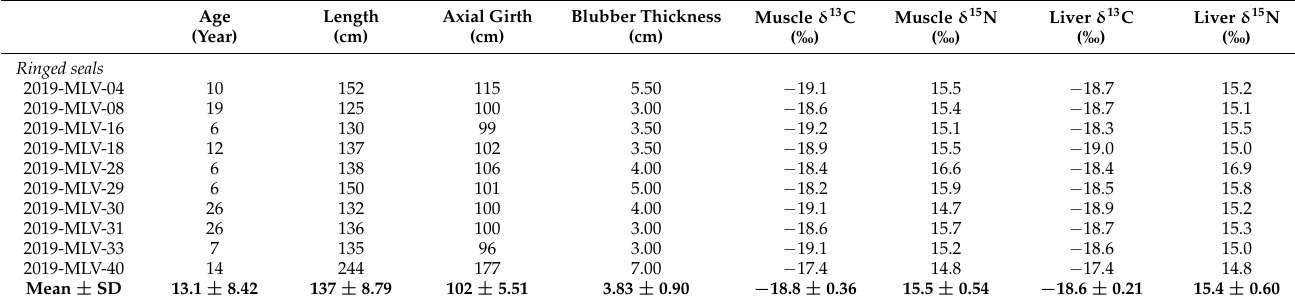
Table 1. Details of individual male adult ringed seals ( n = 10) sampled from Lake Melville in 2019 and male adult belugas sampled from the Eastern Beaufort Sea population in 2009 ( n = 4) and 2017 ( n = 9). Means and standard deviations of ringed seals were calculated without ringed seal #40, which was an